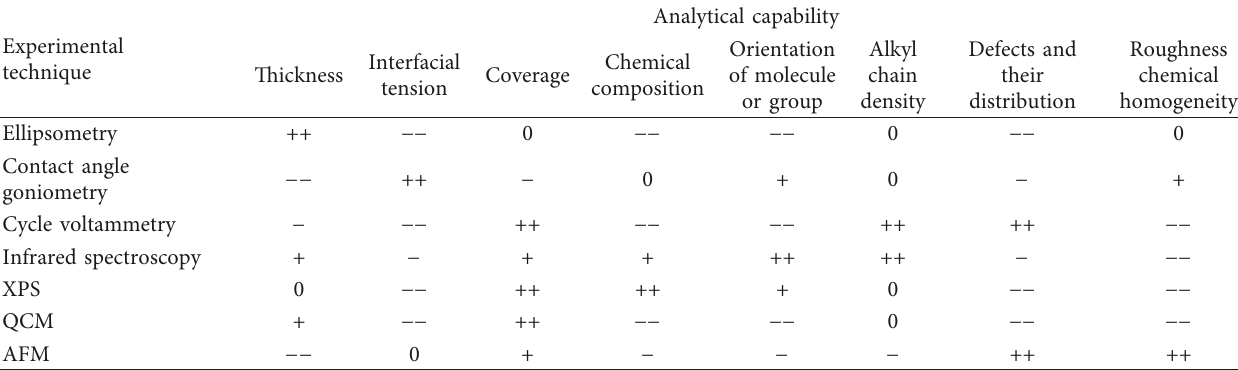
Table 2: Analytical capabilities of commonly used techniques for SAM characterization. Adapted from Liedberg and Cooper [67].